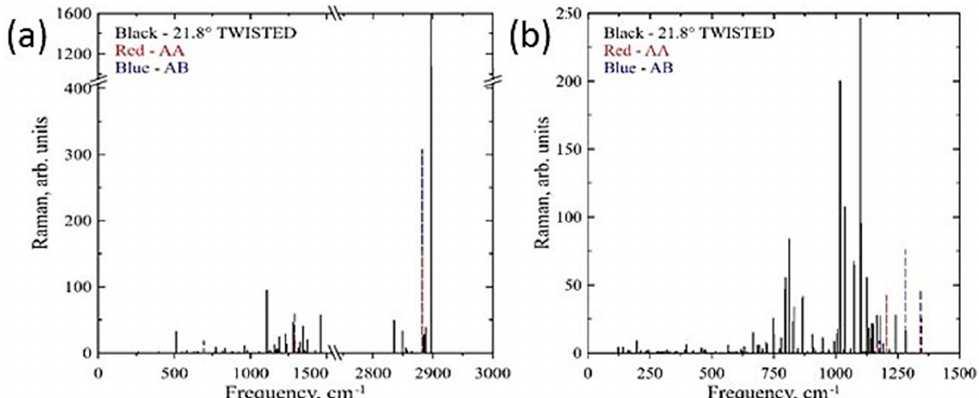
Figure 17. Raman spectra of twisted diamanes Dn21.8 ( a ) and F- Dn21.8 ( b ) in comparison with standard, similar AA- and AB-stacked diamanes [48]. Table 4. Main Raman modes of hydrogenated and fluorinated AB and Dn21.8 diamanes.